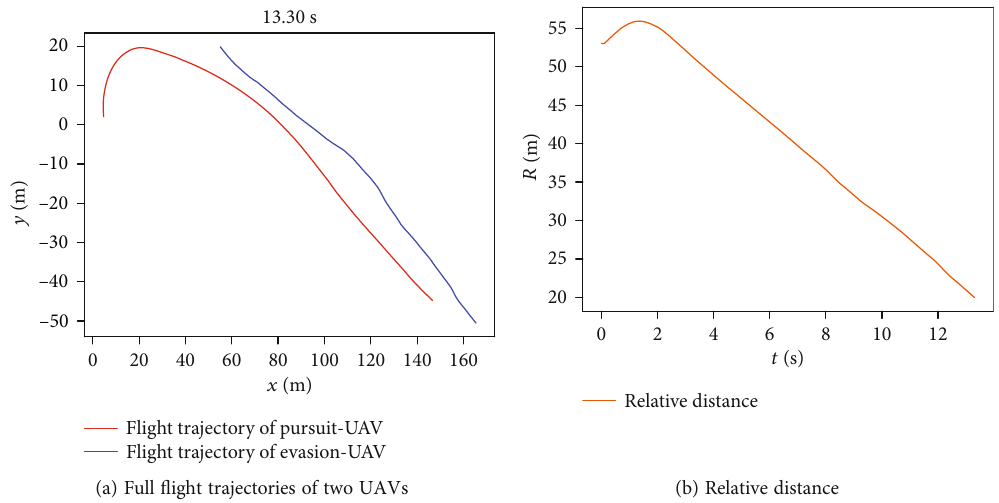
Figure 13: Trajectories of facing evasion-UAV with a random-strategy motion.